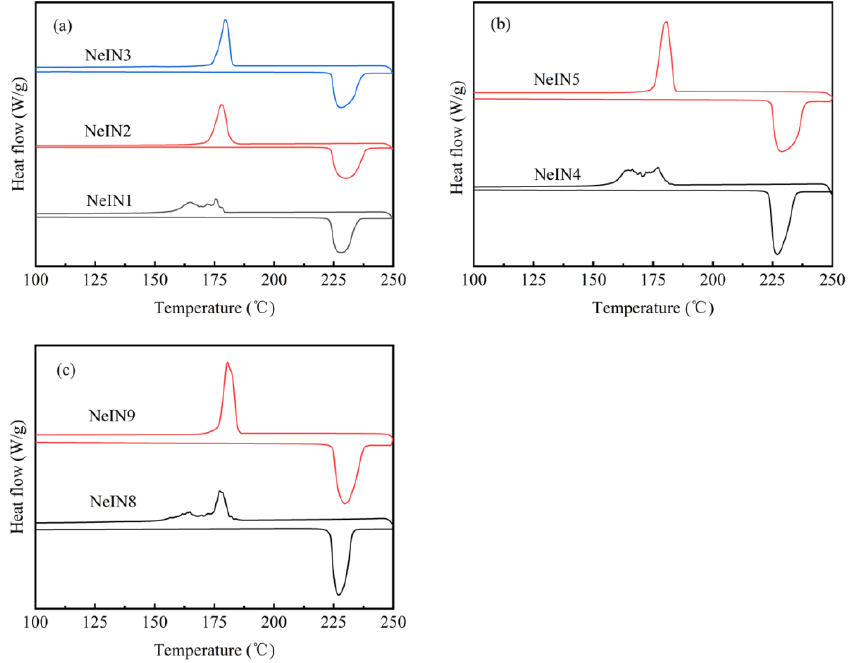
Figure 5. DSC curves of the nanocapsules with various conditions: ( a ) TES/TEOS = 5 mL/9 mL; ( b ) TES/TEOS = 5 mL/10 mL; ( c ) TES/TEOS = 7 mL/9 mL. The SEM micrographs of NeIN1, NeIN2 and NeIN3 with the same TES/TEOS